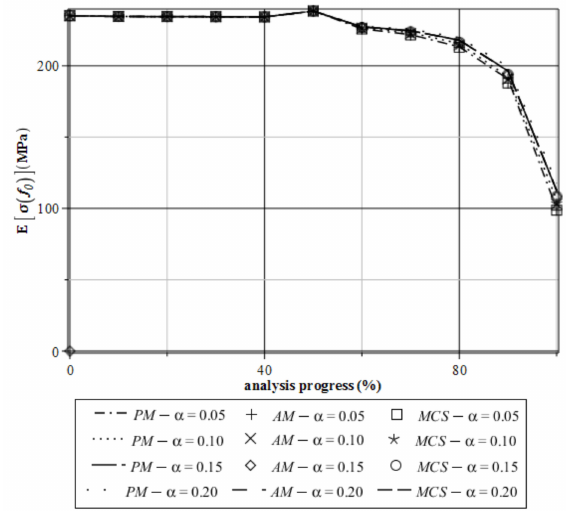
Figure 11. Expectations of the extreme von Mises stress E[ σ (f 0 )] for the specimen.